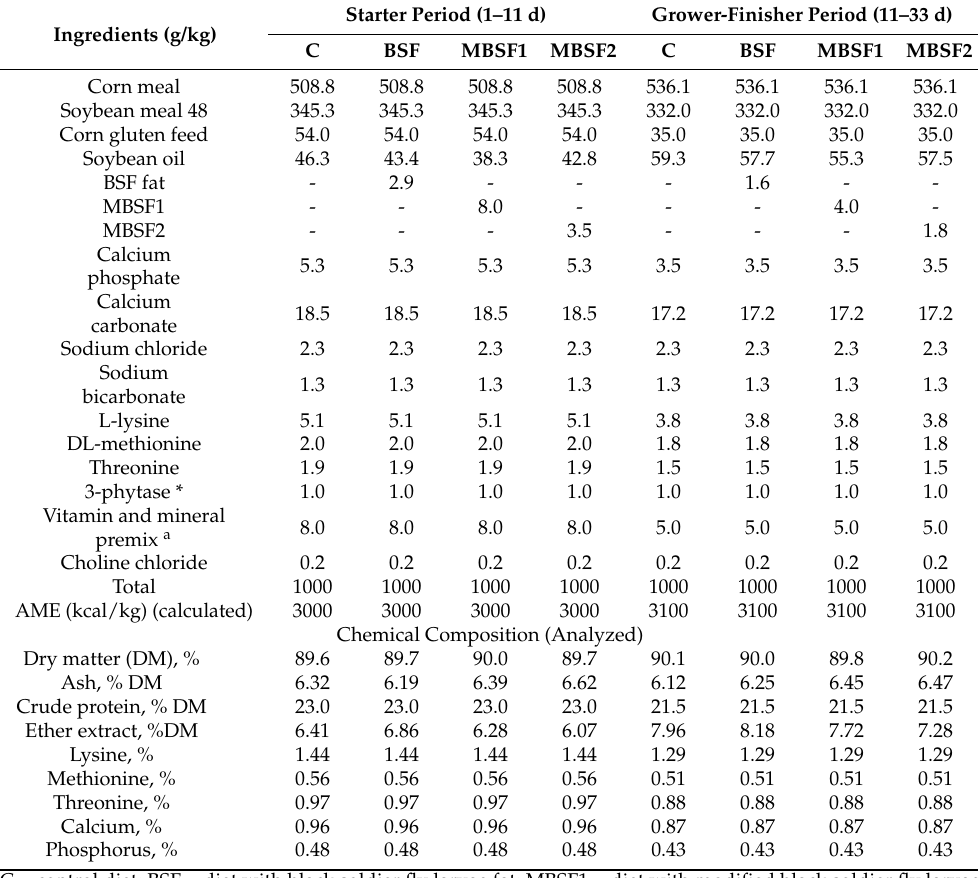
Table 1. Ingredients and chemical composition of the starter and grower-finisher diets. Ingredients (g/kg)